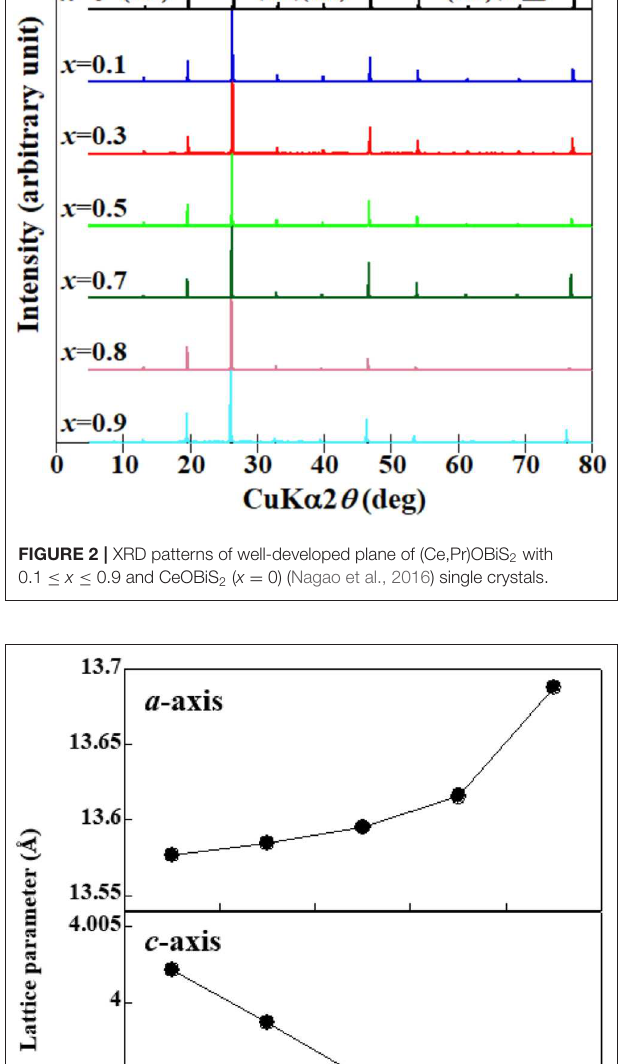
TABLE 1 | Nominal and analytical Pr ratios.